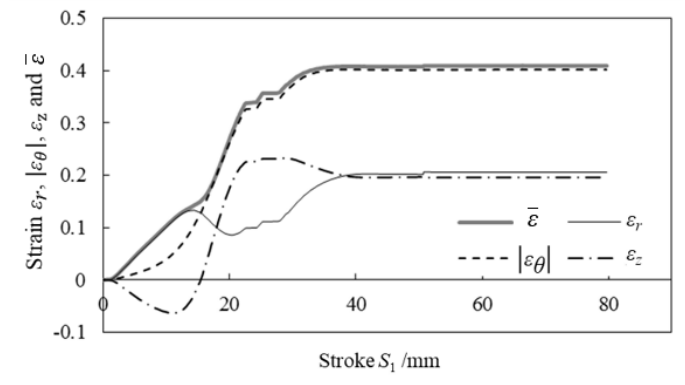
Figure 19. Isotropic ductile-fracture prediction by conventional isotropic ductile-damage model in first forward extrusion.